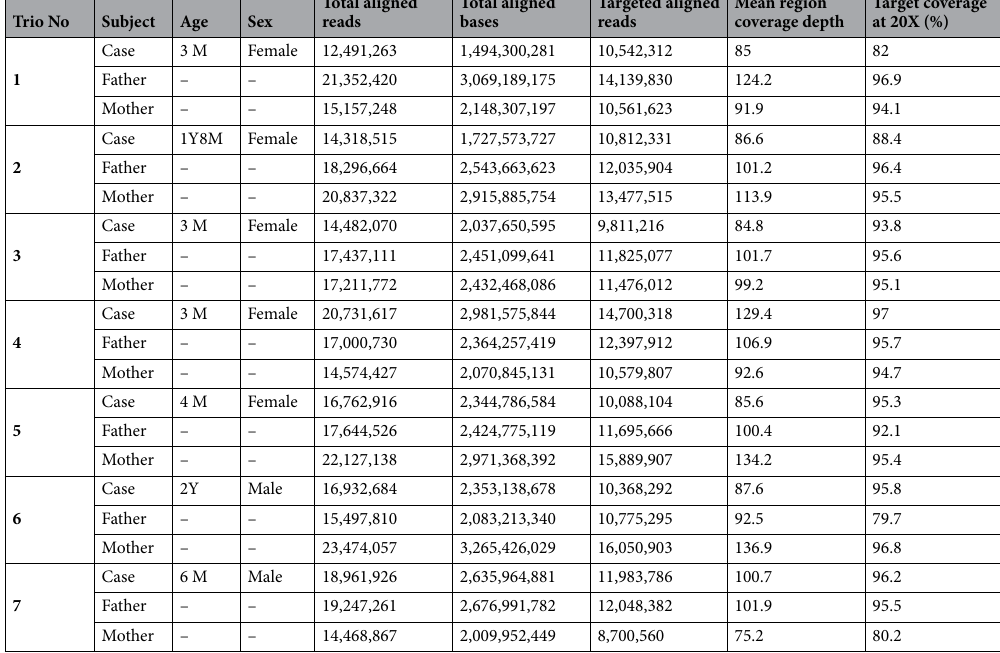
Table 1. Summary of SUDI cases and their parents and results of sequencing analysis. Trio 2 parents had a consanguineous